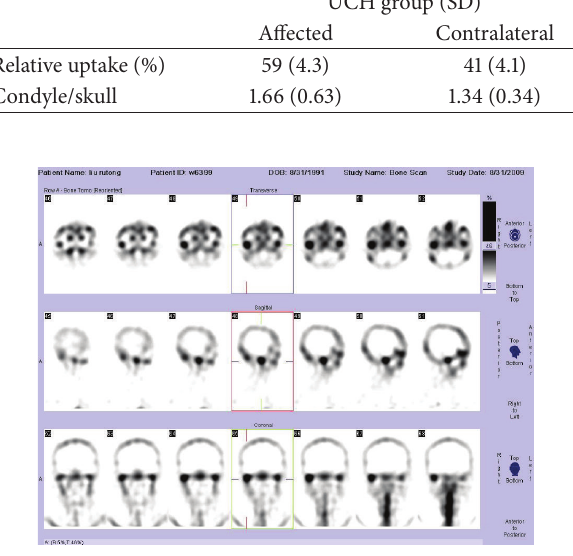
Figure 1: TMJ SPECT images of a patient (male, 21-year old) with right-sided condylar hyperplasia. An abnormally high uptake of radioactivity in the right condyle was observed in the axial, sagittal, and coronal reconstructions relative to the left side.